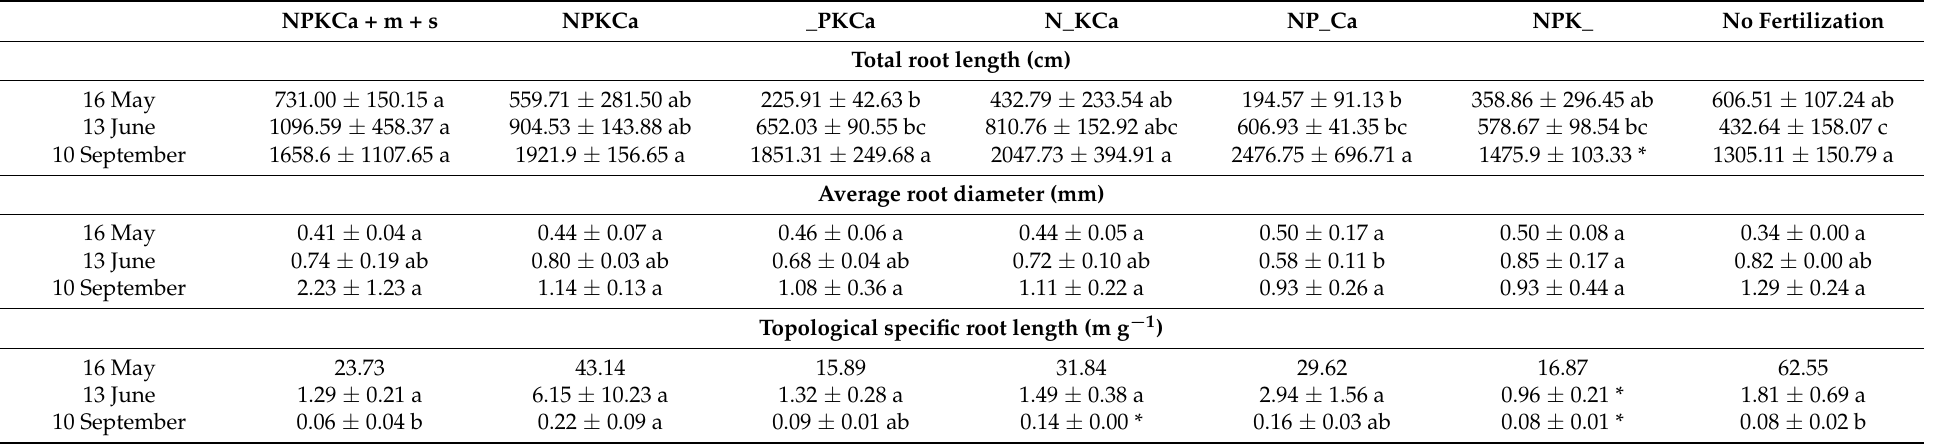
Table 4. Effect of fertilization on the root morphology parameters of sugar beet on three sampling dates in 2019 at the long-term fertilizer experiment Dikopshof, Germany. Mean values of total root length are given in cm, average root diameter in mm and the specific root length in m g − 1 . Different letters indicate significant differences between treatments (ANOVA, α = 0.05). * excluded from the statistical